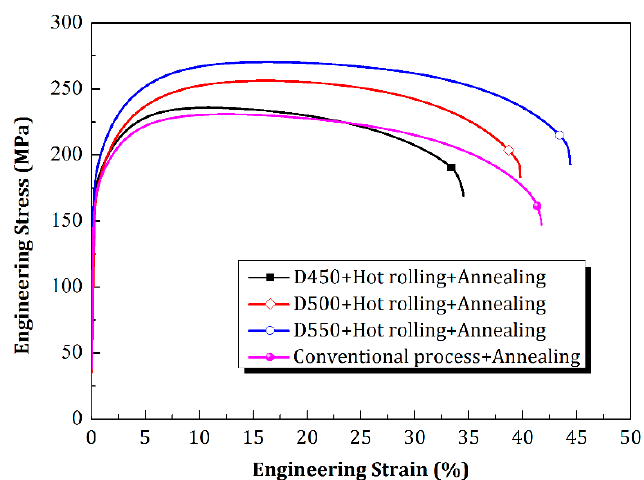
/ Ti LMCs after annealing treatment.